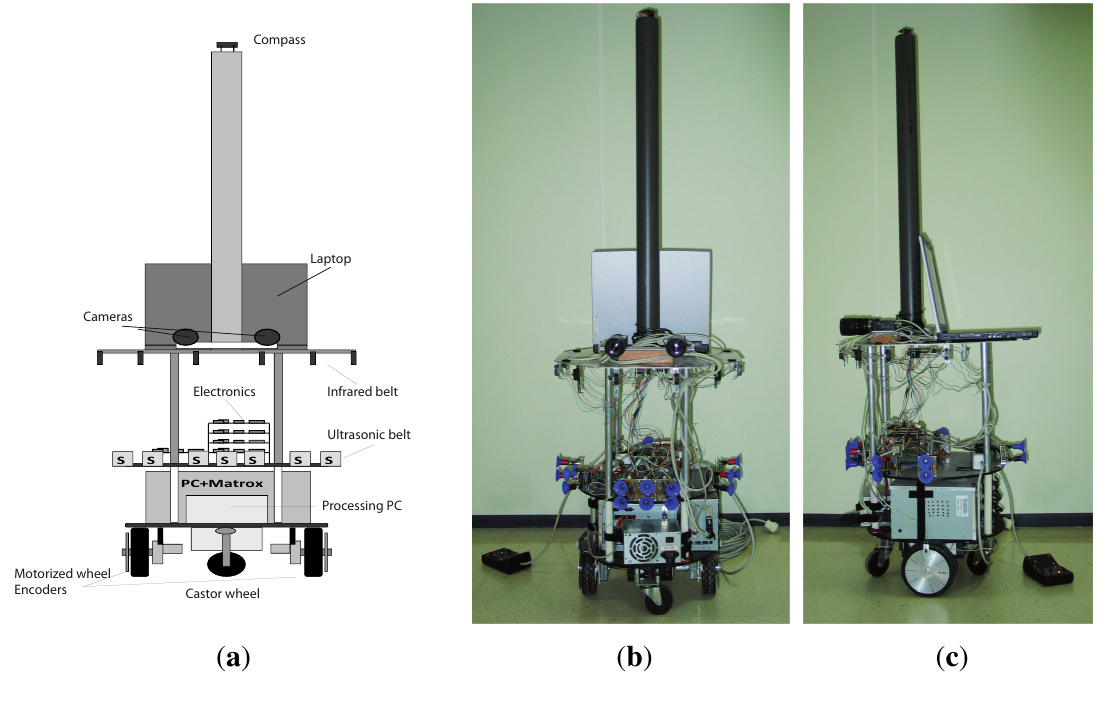
Figure 2. Robot. ( a ) Schema; ( b ) Frontal View; ( c ) Lateral